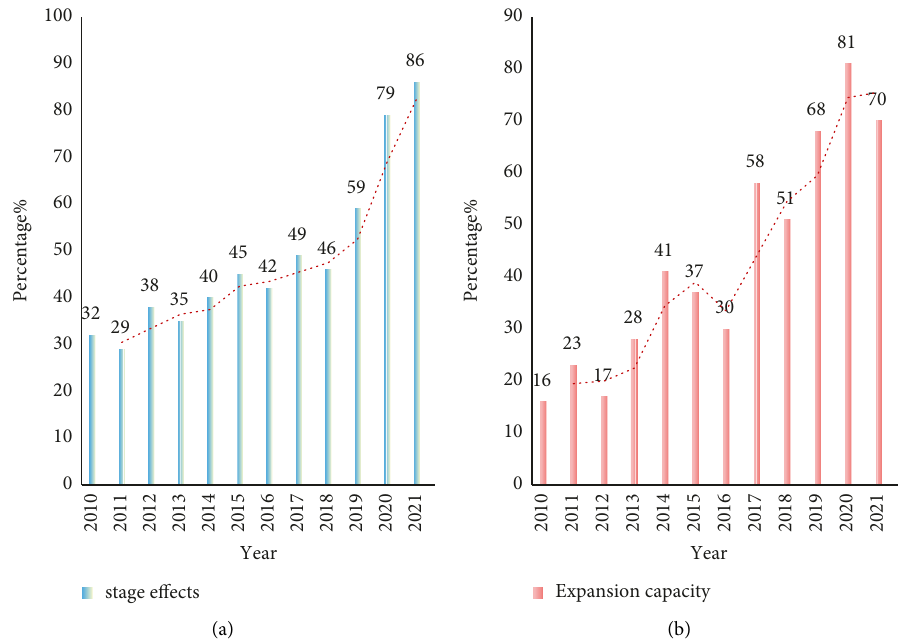
Figure 9: The impact of new media on dance development from 2010 to 2021. (a) The impact of new media onstage effects from 2010 to 2021 and (b) the impact of new media on development space from 2010 to